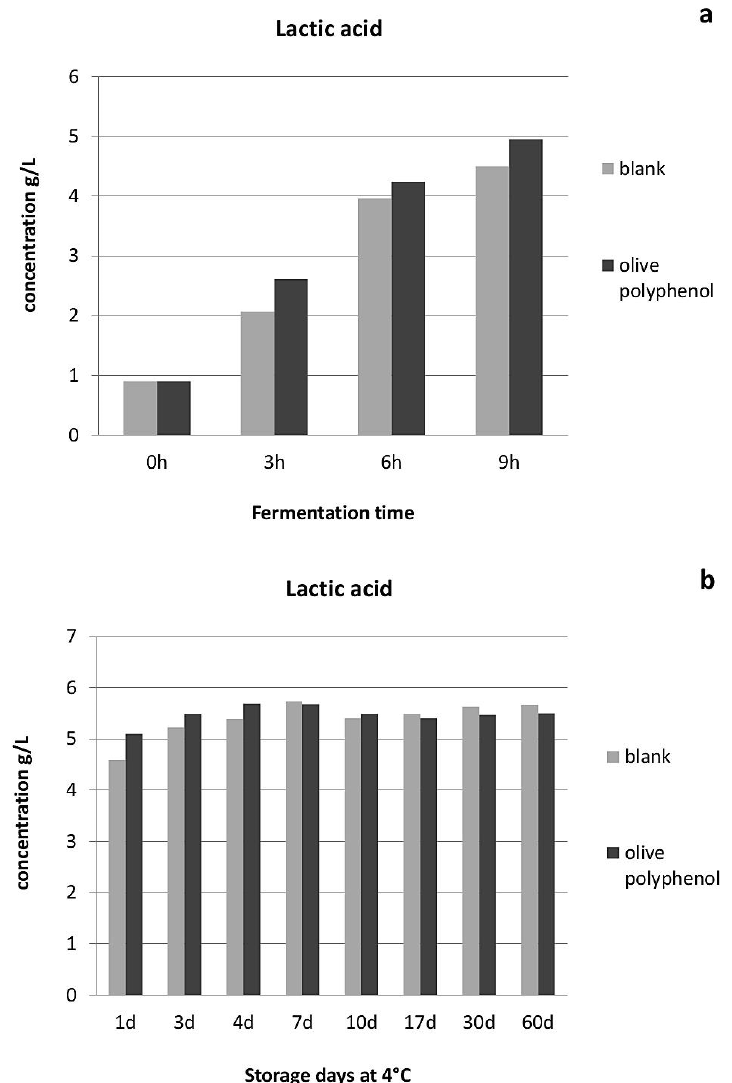
Figure 1. Total acidity (expressed as g/L of lactic acid concentration) during fermentation ( a ) and refrigerated storage ( b ) of yogurts with or without addition of 1250 ppm of olive polyphenols.